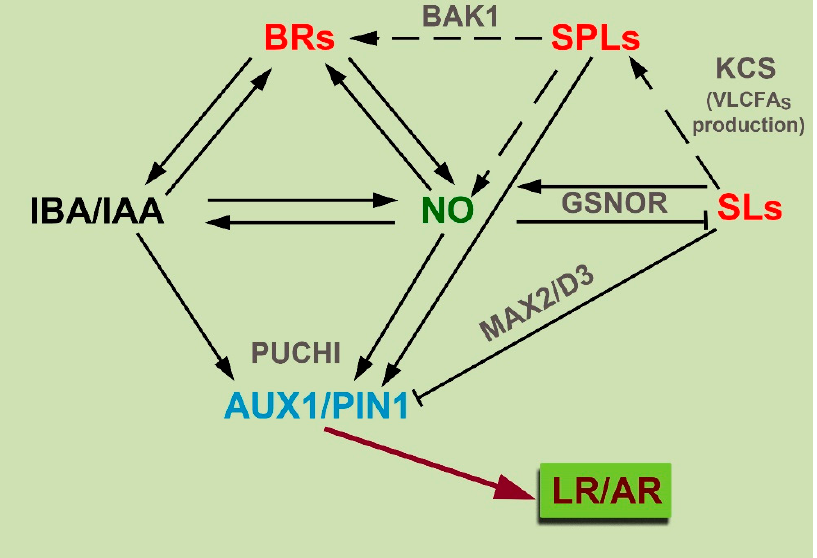
Figure 3. Model explaining the hypothesis of a central role of nitric oxide (NO) in the modulation of promotive/antagonistic actions of brassinosteroids (BRs), strigolactones (SLs), and sphingolipids (SPLs) in the control of the auxin-induced lateral and adventitious (LR/AR) root formation. The